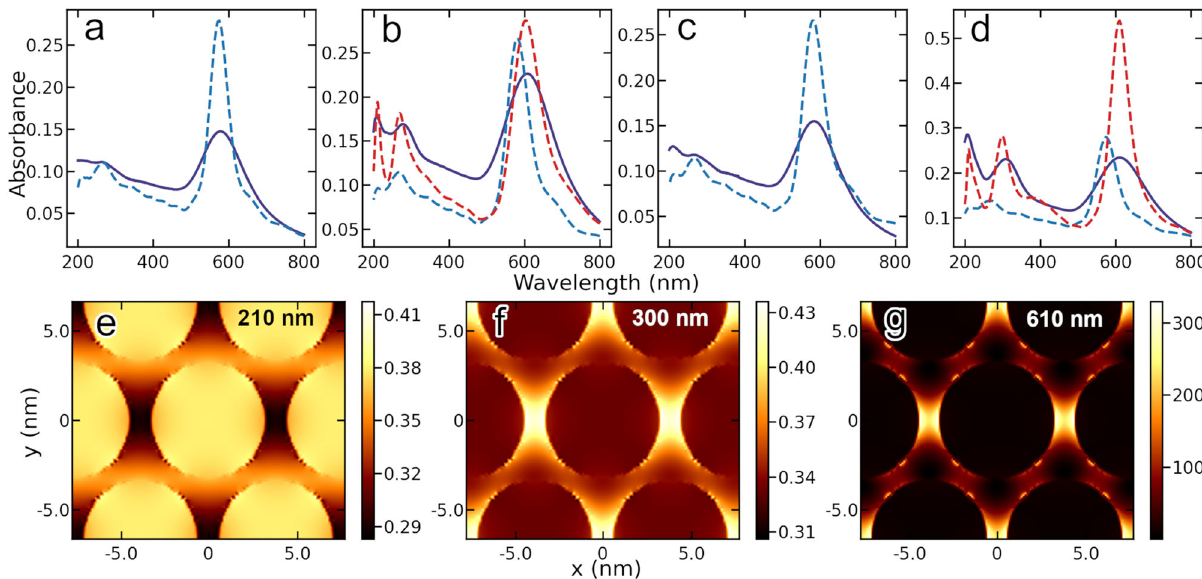
Fig. 5 UV – Vis spectra and fi nite difference time domain modeling for nanoparticle fi lms fabricated using various molecules. Solid lines: experimental UV – Vis absorption spectra of fi lms assembled with 5.99 ± 0.48 nm NPs. Dashed lines: numerical model including the effects of both conductivity, σ , and molecular extinction factor, κ m , with enhancement factor, Λ . a benzenethiol (blue: σ = 4 × 10 3 and Λ = 1), ( b ) benzenedithiol (blue: σ = 6 × 10 3 and Λ = 1; red: σ = 10 × 10 3 and Λ = 1.4 × 10 6 ), ( c ) biphenylthiol (blue: σ = 6 × 10 3 and Λ = 1), and ( d ) biphenyldithiol (blue: σ = 6 × 10 3 and Λ = 1; red: σ = 12 × 10 3 and Λ = 1.7 × 10 6 ). Modeled normalized electric fi eld intensity (| E |/| E 0 |) 2 maps for biphenyldithiol cross-linked fi lms at ( e ) 210 nm, ( f ) 300 nm and ( g ) 610 nm. Incident electric fi eld is x Figure 5e – g show electric fi eld intensity maps at resonances (210, 300, and 610 nm, respectively) for biphenyldithiol X-NS excited by an x-polarized incident fi eld. Bright and dark regions represent strong and weak fi eld intensities, respectively. These results illustrate collective modes of X-NS and corresponding UV – Vis absorption features. The model predicts that fi eld intensities are strongest within the NPs at 210 nm (even though it is a resonance associated with the sulfur moiety on the NP sur- face) and between NPs at 300 nm ( π – π * transition). At 610 nm (~surface plasma resonance), fi eld enhancement is concentrated in regions where NPs are closest, also known as hot-spots. These